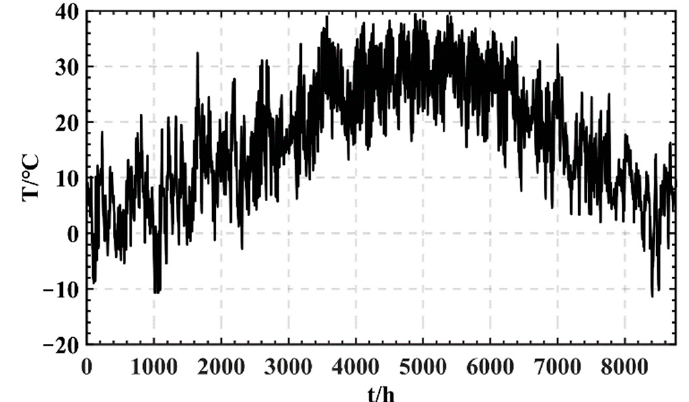
Figure 6. Annual distribution of temperature.